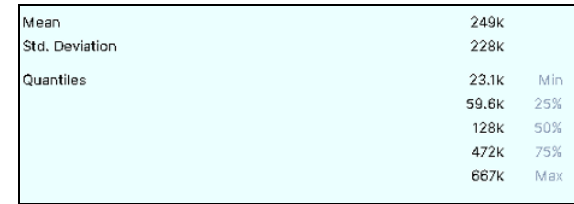
Fig.7. Descriptive statistics of the confirmed cases